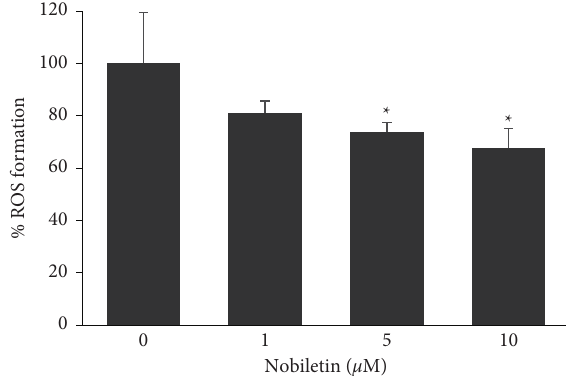
Figure 4: Effect of nobiletin (0–10 μ M) on hydrogen peroxide- induced ROS formation. Data are presented as mean ± SD. ∗ indicates significant differences between the treatment group and untreated control group at p < 0 . 05.